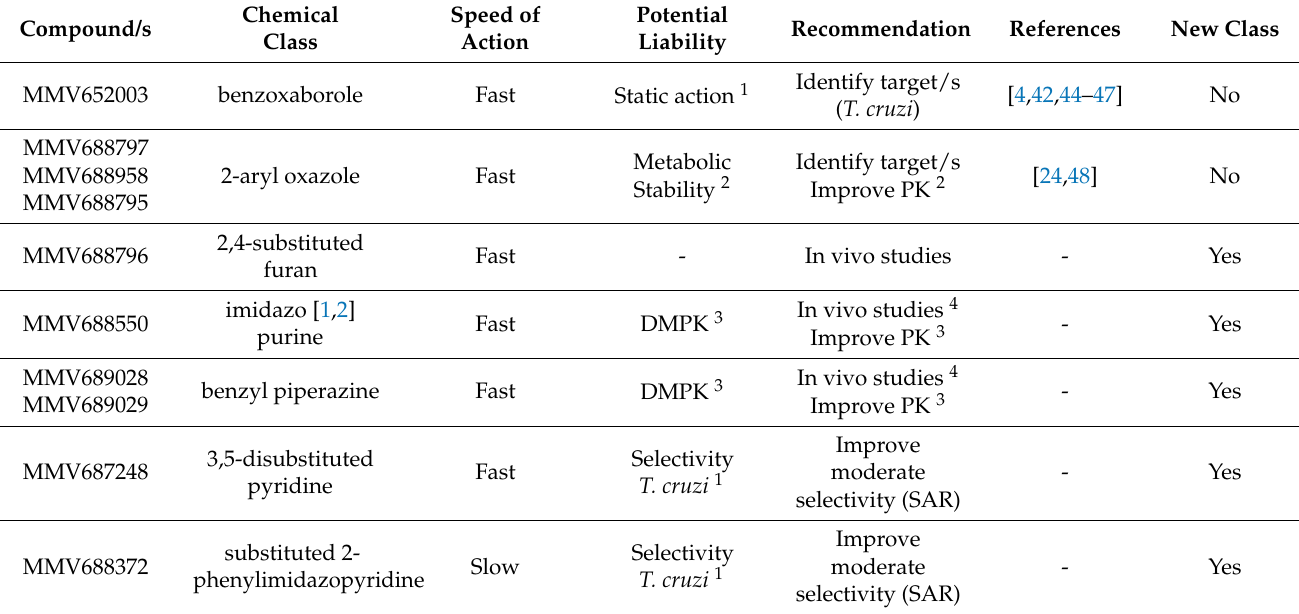
Table 5. Prioritised compounds from the Pathogen Box with activity against both T. cruzi and T. brucei recommended for